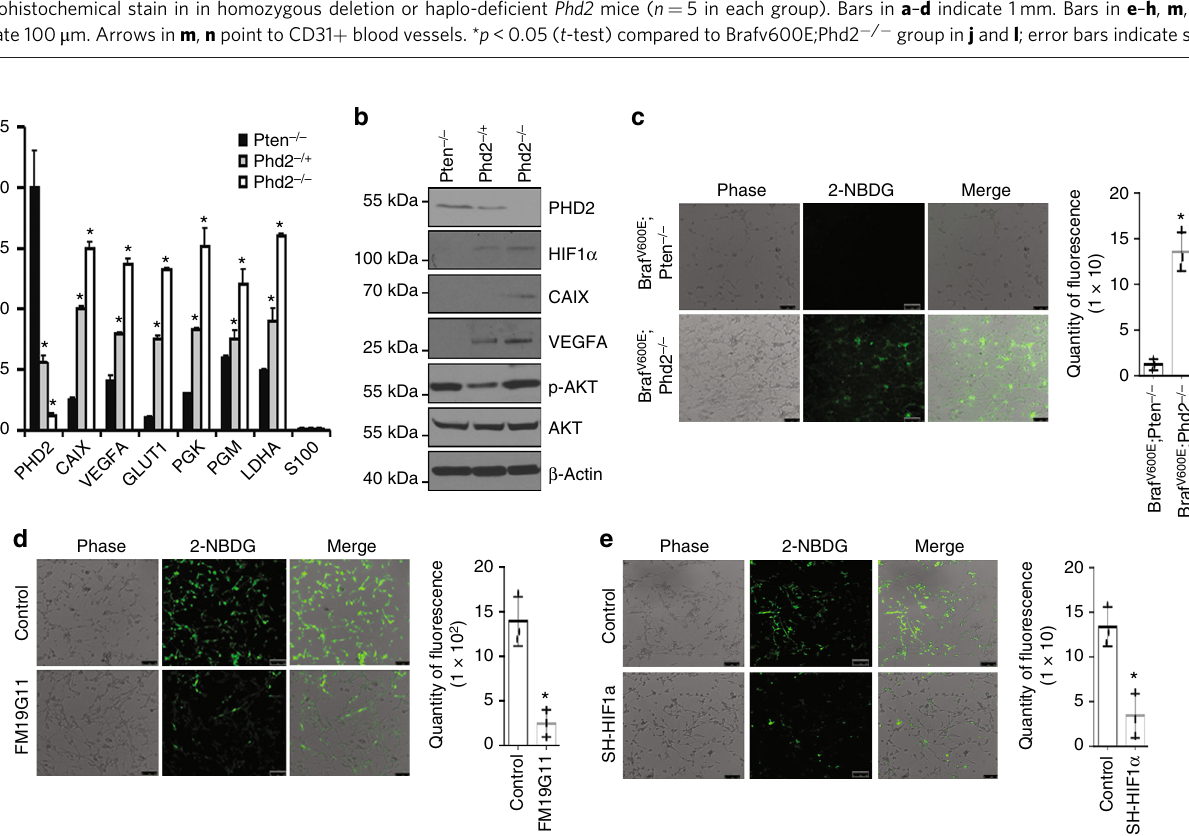
Fig. 4 Haplo-de fi cient Phd2 is suf fi cient to cooperate with BRaf V600E to induce melanoma in mice. a – h Haplo-de fi cient Phd2 is suf fi cient to cooperate